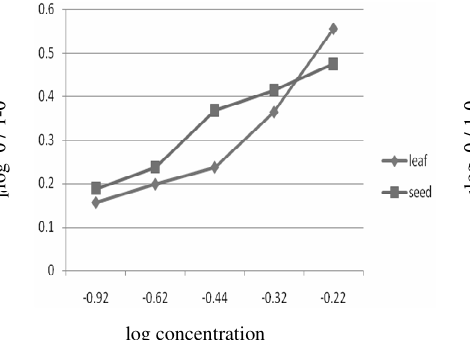
Figure 1. Langmuir adsorption isotherm of leaves extract for aluminium in 0.5N H with inhibitor concentration